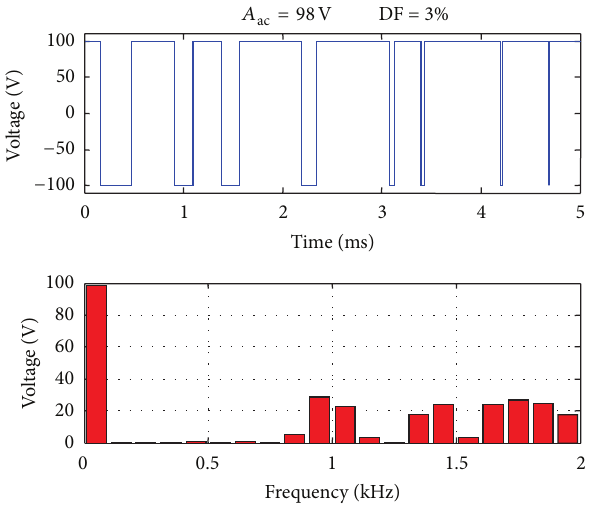
Figure 6: Optimal conventional design with 𝑀 = 8 switching cycles. PWM signaland harmonicdistributionfortheAC amplitude = 98 V with a fundamental frequency of 50 Hz and 𝑉 𝐴 ac